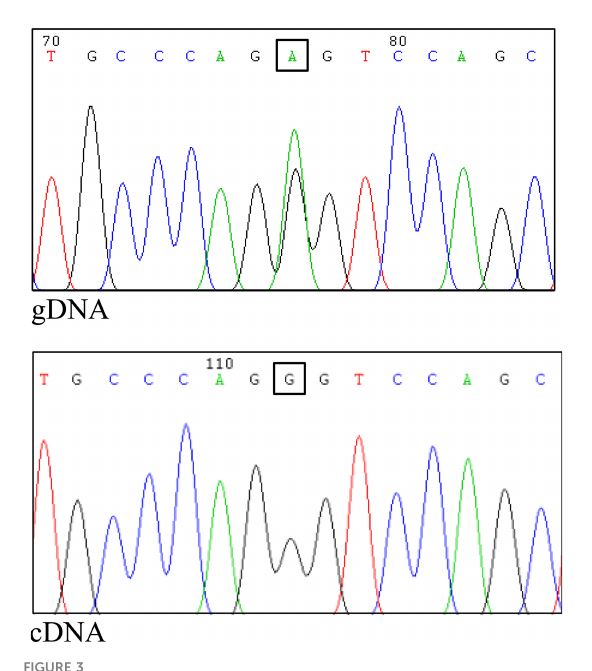
FIGURE 3 Assessment of allele-speci fi c expression of the normal BRCA1 transcript. The common variant c.4837A>G, mapped to BRCA1 exon 16, was proven to be heterozygous in the genomic DNA (gDNA) of the proband ’ s brother (upper panel). The speci fi c ampli fi cation of cDNA fragment maintaining exon 22 (normal transcript) and including the c.4837A>G variant was performed using a forward primer in exon 16 and a reverse primer in exon 22. The sequencing of the RT-PCR product showed a mono-allelic expression of the normal transcript (lower panel), indicating a complete spliceogenic effect of the c.5406+6T>C